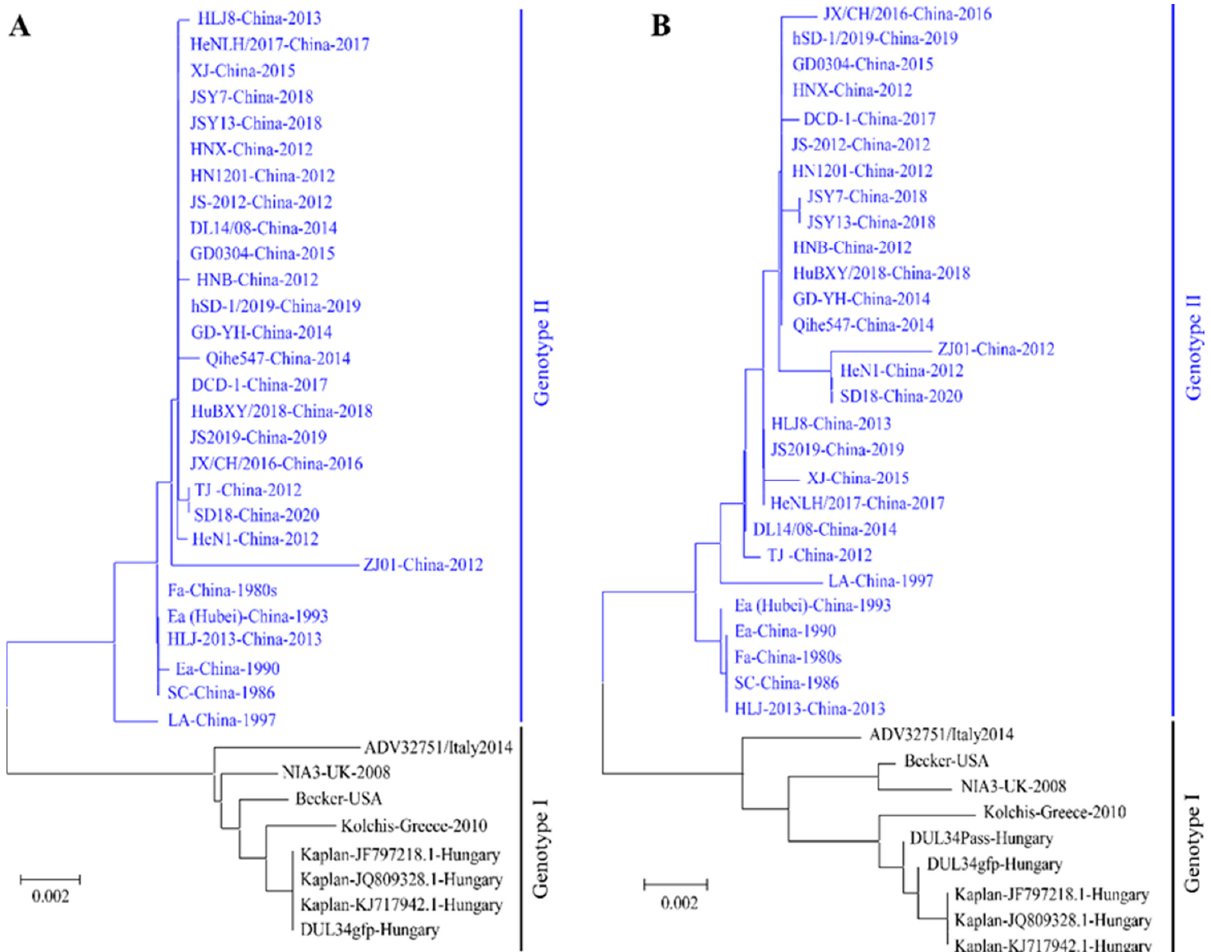
Figure 2. The phylogenetic analysis of PRV gI and gE genes. ( A ) Phylogenetic analysis of PRV gI gene sequences. ( B ) Phylogenetic analysis of PRV gE gene sequences. Both maximum likelihood (ML) trees were constructed by using MEGA X software.